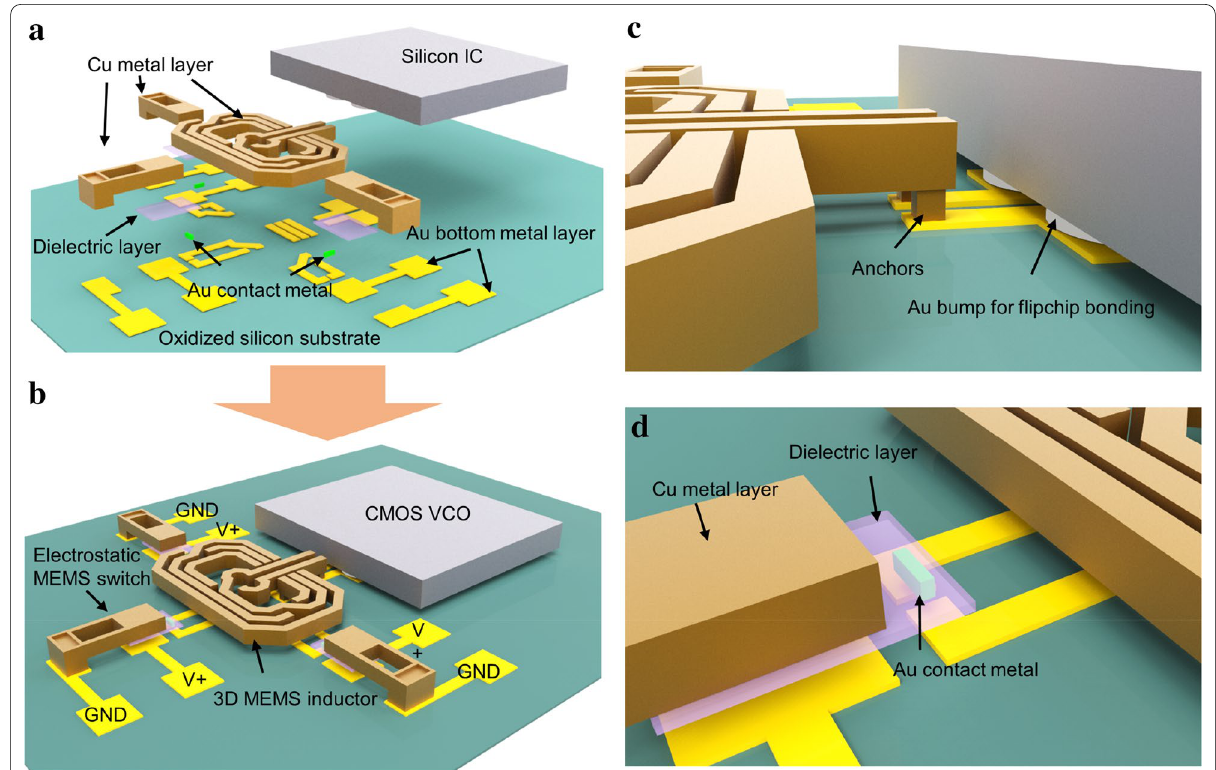
Fig. 2 Schematic diagrams of the proposed VCO integrated with the MEMS tunable inductor. a Schematic diagram of each component layer of the proposed VCO. b Schematic diagram of the proposed VCO composed of the MEMS tunable inductor with three electrostatically actuated RF MEMS switches, a 3D MEMS inductor, and a CMOS VCO. c Close‑in image of the RF MEMS switch with a contact metal and bottom metal layer of the MEMS inductor. d Close‑up image of the anchors that connected the MEMS inductor and the CMOS